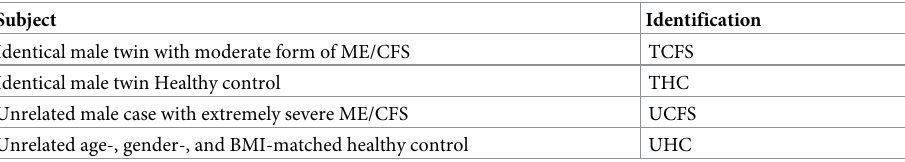
Table 1. Participants sample IDs, used for the TEM